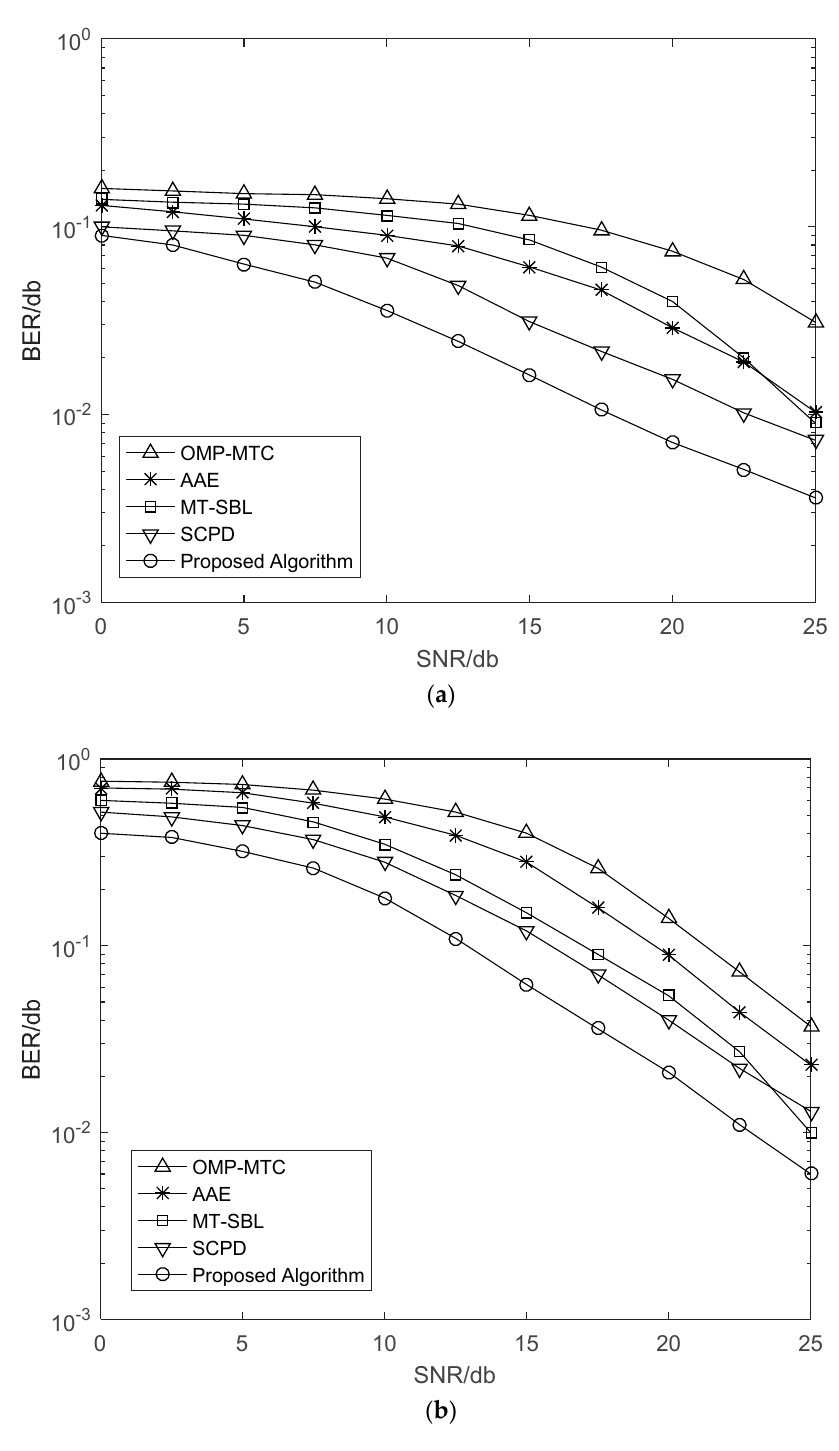
Figure 3. BER performance against SNR with a single vehicle, G T = 128, G R = 32, N R = 16, and N T = 64 antennas. ( a ) v = 120km/h. ( b ) v = 200km/h.